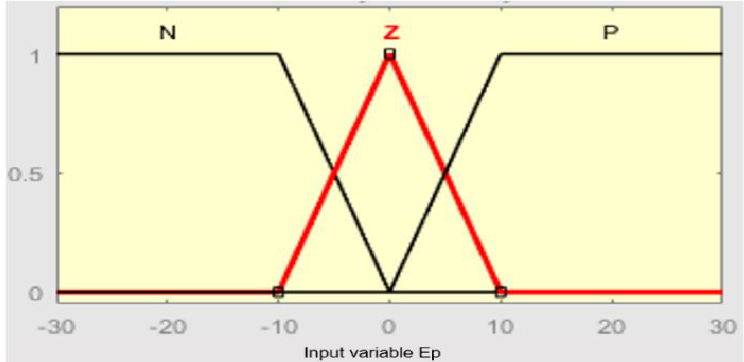
Figure 5. Linguistic variable E V (k).